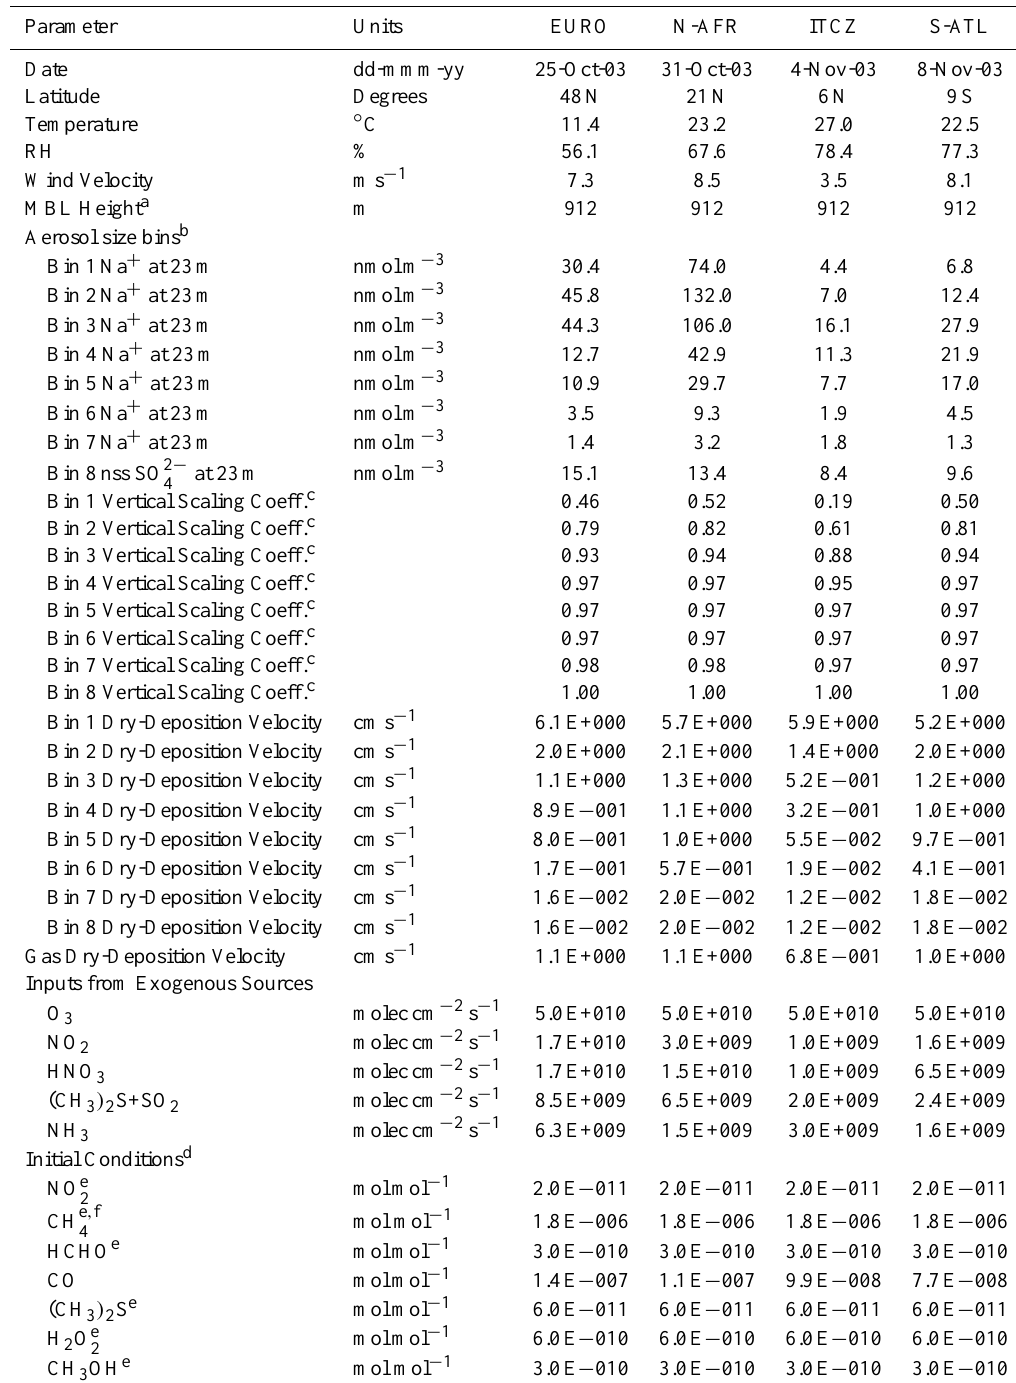
Table 2. Model parameterization and initialization. Unless otherwise noted, the model was parameterized and initialized based on median values for measured and calculated results from the